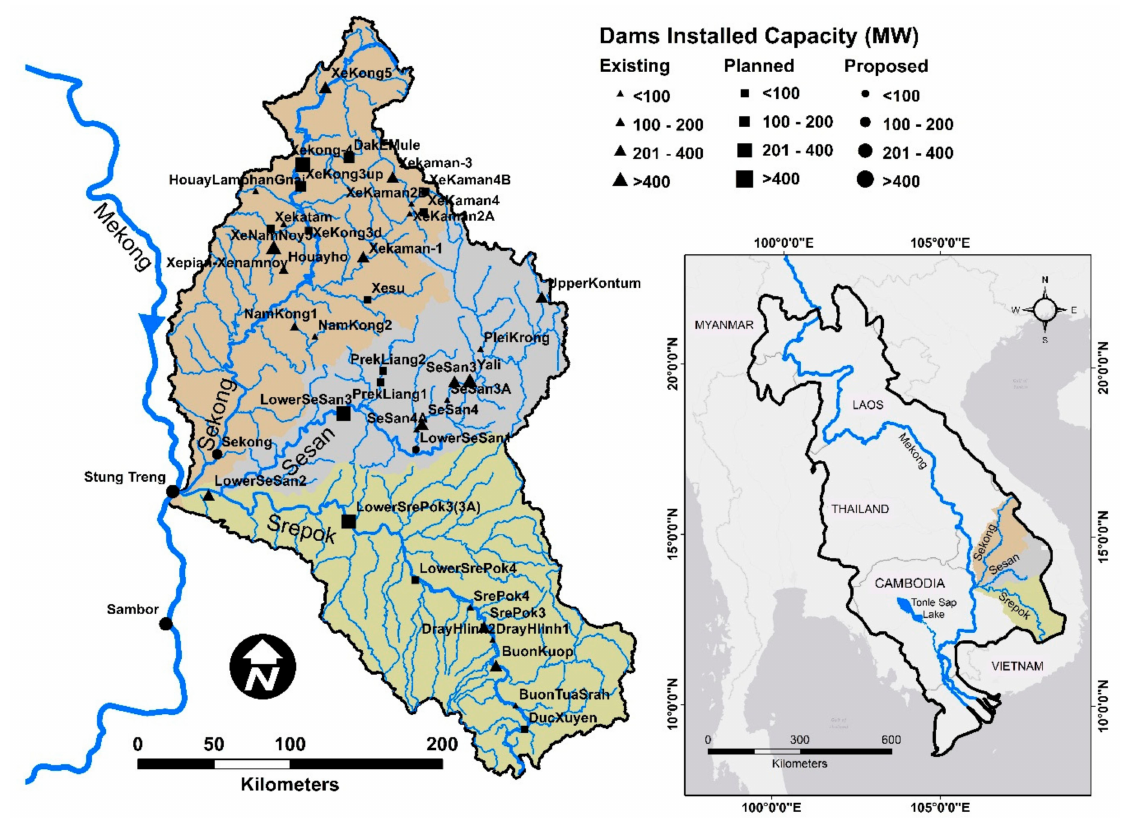
Figure 1. The Sekong, Sesan, and Srepok (3S) Basin with existing and planned hydropower dams. The 3S Basin drains southern Lao PDR, Vietnam’s Central Highlands, and